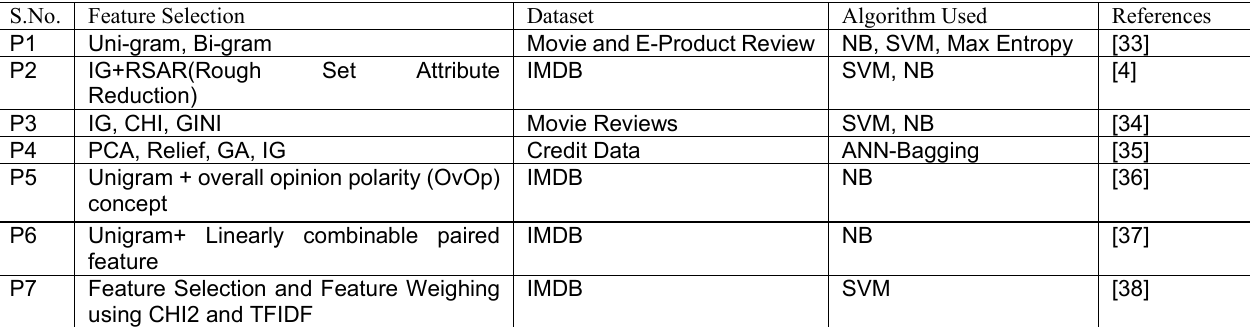
Table 1. Review of Feature Selection Techniques in Sentiment Classification